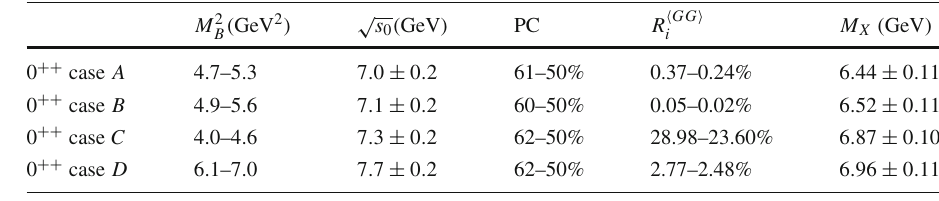
the ground states for [ 8 ] ⊗ [ 8 ] ⊗ [ 8 ] , [ 8 c ] c c ¯ c c c b ¯ c , b ¯ b c ¯ b ⊗ [ 8 ] and [ 8 c ] , where cases c b ¯ b b ¯ b A to D correspond to the currents in Eqs.